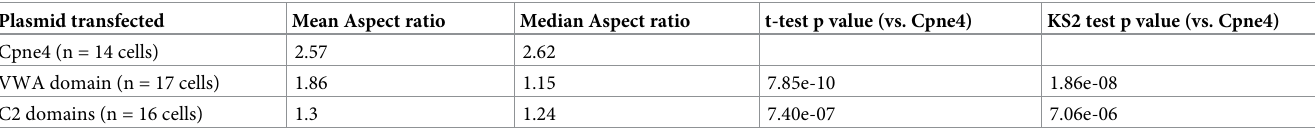
Table 2. Aspect ratios of transfected HEK293 cells. Plasmid